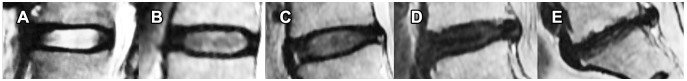
Grading system for assessment of MRI features of lumbar disc degeneration.Grade 1 (A)—homogeneous disc structure, normal disc height and distinction of nucleus and annulus is clear; grade 2 (B)—nonhomogeneous shape with horizontal bands, some blurring between nucleus and annulus; grade 3 (C)—nonhomogeneous shape with blurring between nucleus and annulus, shape of the annulus still recognizable; grade 4 (D)—nonhomogeneous shape with hypointensity, distinction between nucleus and annulus impossible, disc height usually decreased; grade 5 (E)—same as grade 4 but with a collapsed disc space.